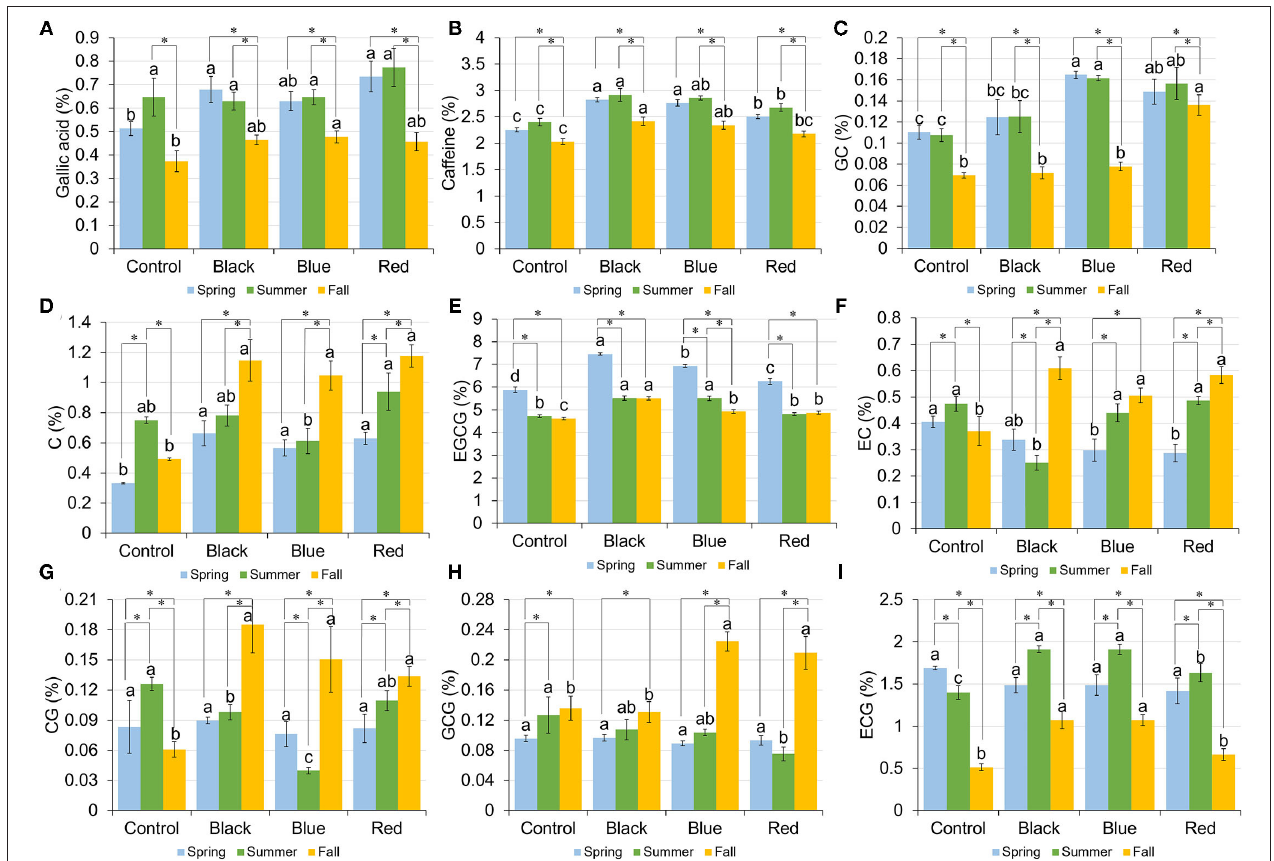
FIGURE 4 | Content of gallic acid (A) , caffeine (B) , gallocatechin (GC) (C) , catechin (C) (D), epigallocatechin-3-gallate (EGCG) (E) , epicatechin (EC) (F) , catechin-3-gallate (CG) (G) , gallocatechin-3-gallate (GCG) (H) , and epicatechin-3-gallate (ECG) (I) in tea leaves collected from plants under different shade treatments in spring, summer, and fall. Contents were presented as percent of dry matter basis. Different letters on top of the same-colored columns represent significant difference between the shade treatments within one season; *connected different columns represent significant difference within one shade treatment between seasons. All the significant differences were indicated by Tukey’s HSD test at p ≤